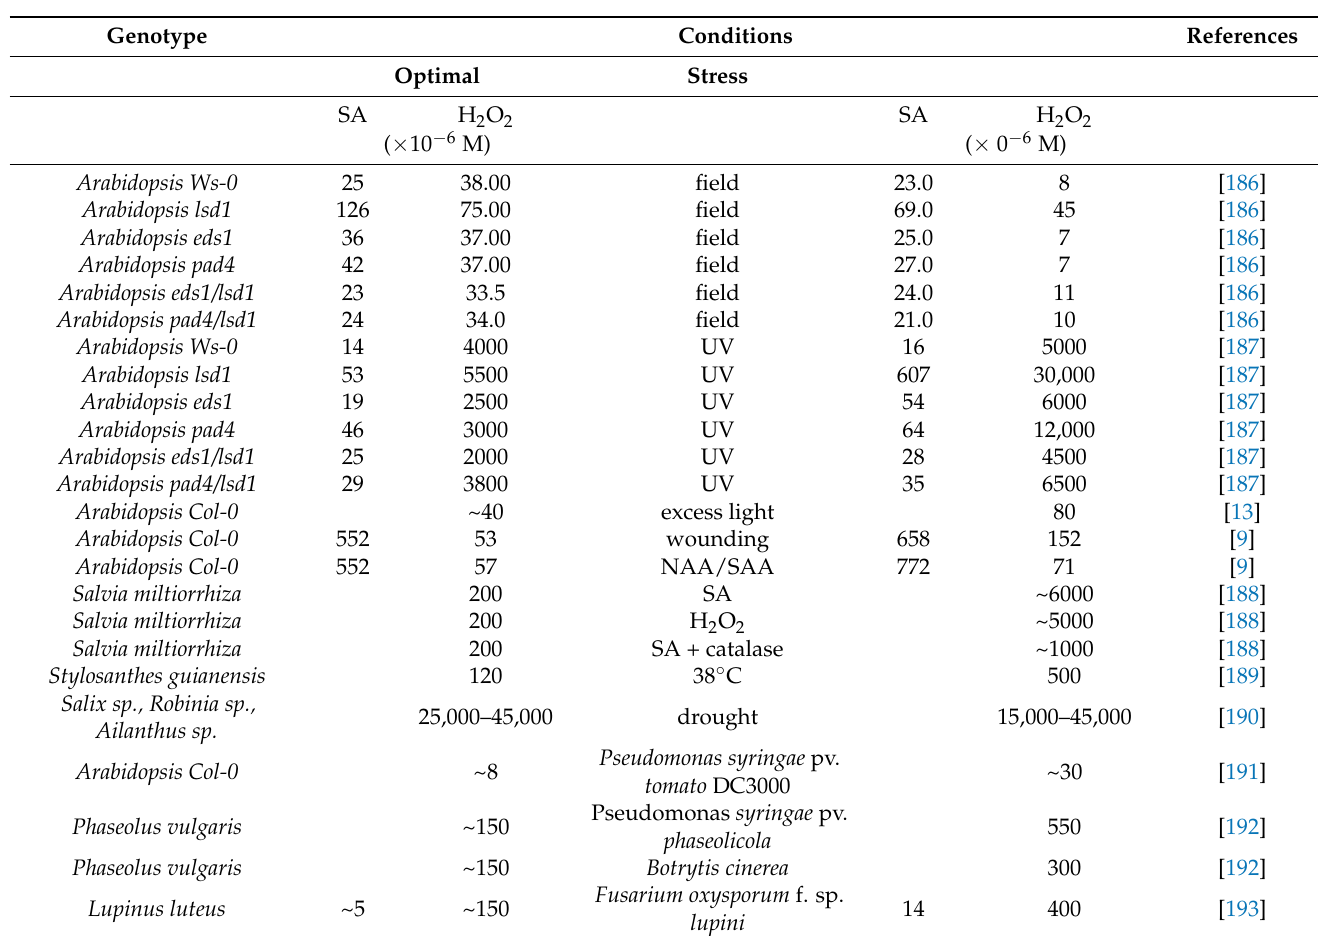
Table 3. Endogenous hydrogen peroxide (H 2 O 2 ) and salicylic acid (SA) levels in plant leaves of different species and genotypes in stable optimal (laboratory) conditions and under abiotic and biotic